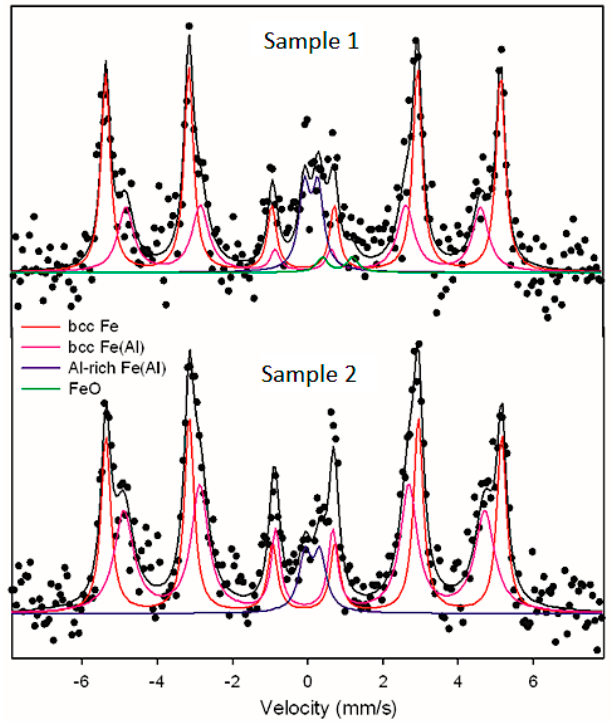
Figure 12. Results of Mössbauer spectroscopy.